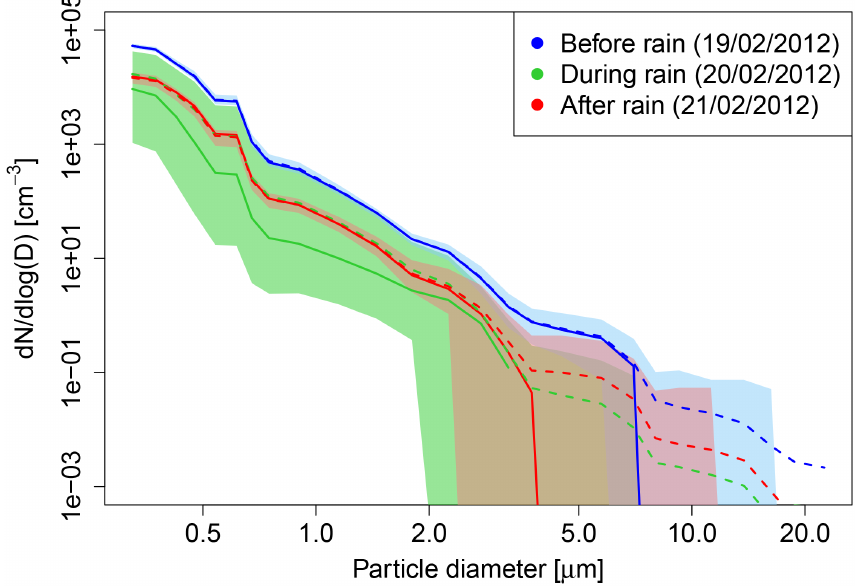
Figure 7. Median (solid lines) and mean (dashed lines) number size distributions for the minutes before (blue), during(green) and after (red) the rain event on 20 February 2012. The coloured blue, green and red areas are limited below and above by the 5th and the 95th percentiles of the correspondent